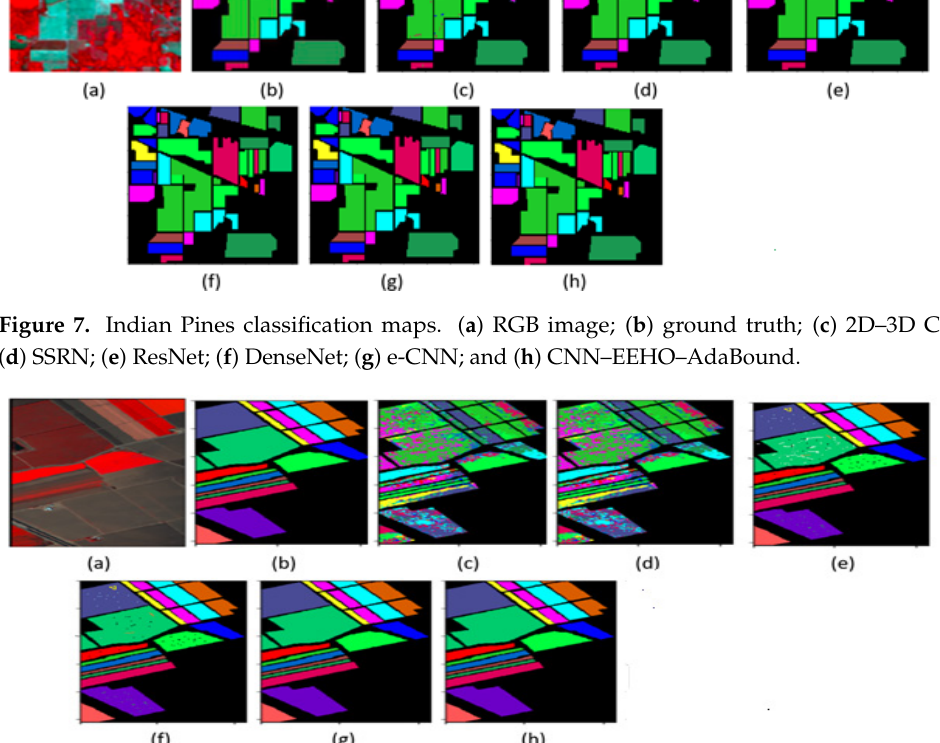
Figure 8. Salinas classification maps. ( a ) RGB image; ( b ) ground truth; ( c ) 2D–3D CNN; ( d ) SSRN; ( e ) ResNet; ( f ) DenseNet; ( g ) e-CNN; and ( h ) CNN–EEHO–AdaBound.